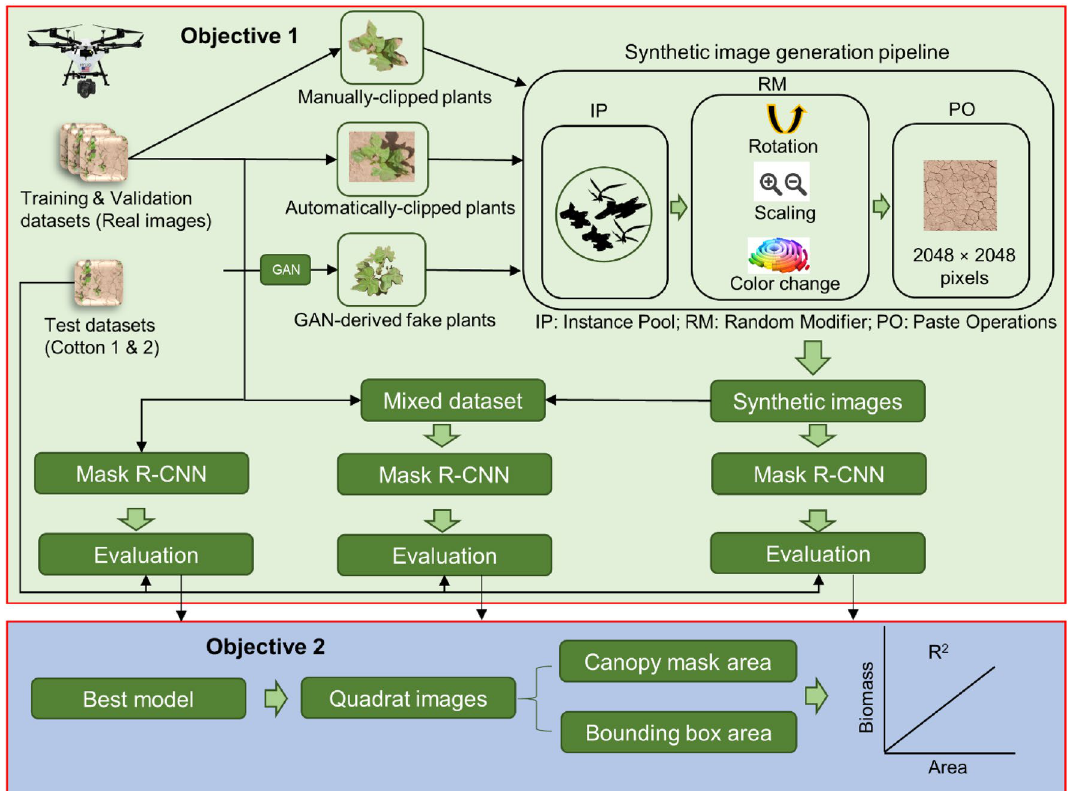
Figure 1. Workflow diagram for the methodology implemented in this study. The pale green and blue sections show the schematic for objectives 1 and 2, respectively. Objective 1 aimed at testing several models with different-source input images, whereas the objective 2 determined the predictability of model results to estimate above-ground biomass of